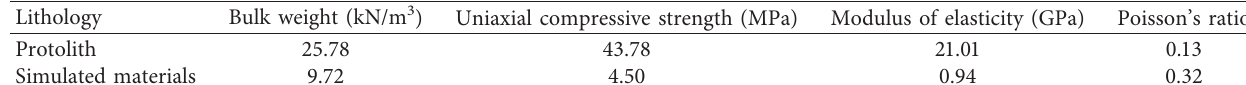
Figure 8: Schematic diagram showing the installation of the force sensor. Table 2: Mudstone material physical parameters.